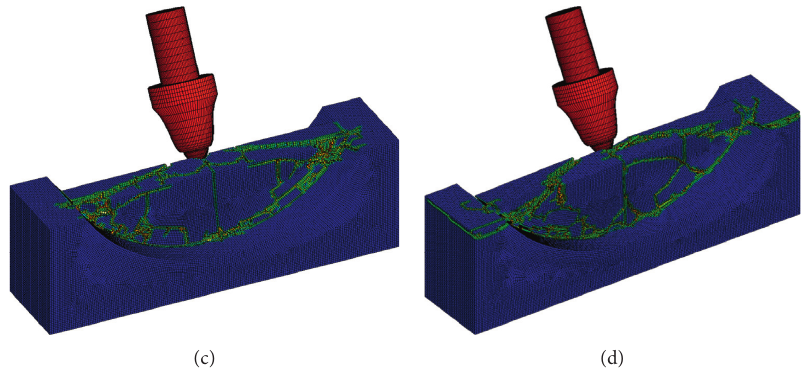
Figure 8: The cutting results of conical pick cutting arc rock plate with various width.